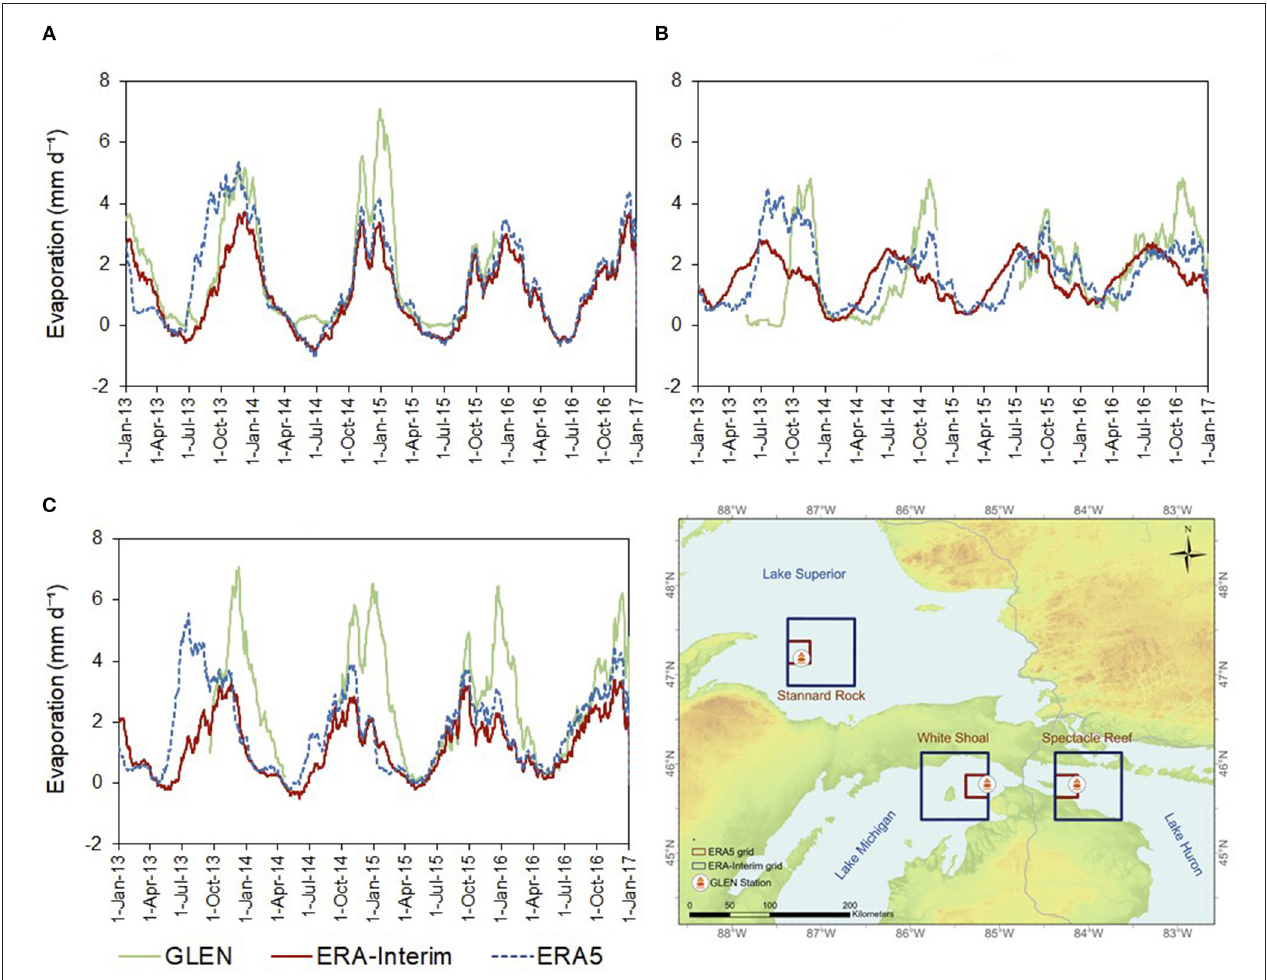
FIGURE 8 | 30-day running mean evaporation rate (mm/day) for three GLEN stations (location shown on map) and corresponding magnitudes for ERA-Interim (0.75 ◦ ) and ERA5 (0.25 ◦ ) grid cells. The running mean is computed after pre-processing and removal of erroneous and extreme values in the GLEN station data. (A) Stannard rock. (B) White Shoal. (C) Spectacle